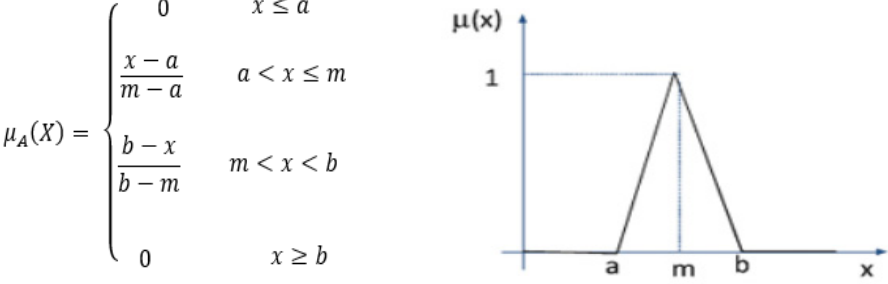
Figure 8. Triangular membership function for fuzzy system inputs and outputs.